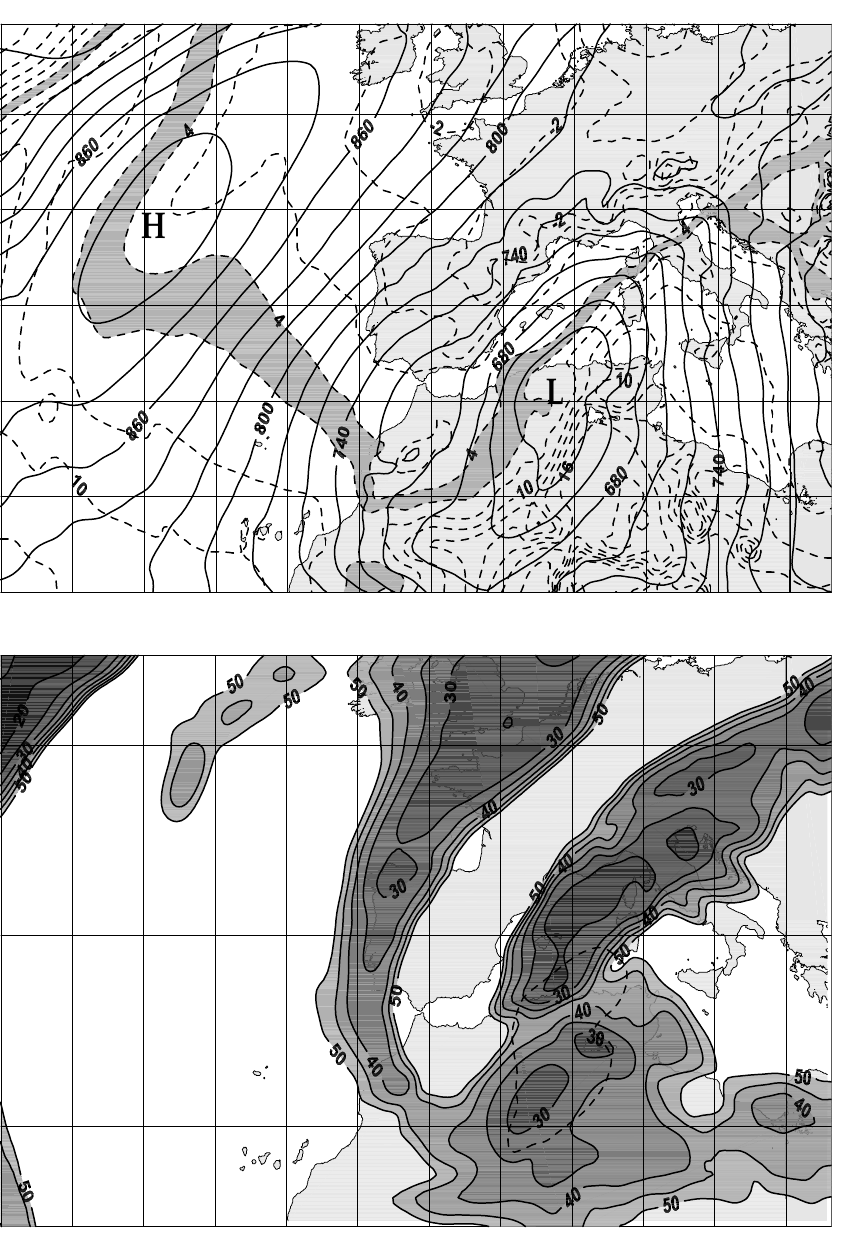
Fig. 11. C20–22 Simulation. e- folding time (hours) shorter than 50h for the most unstable wave, as diag- nosed by the linear shear baroclinic in- stability Eady model for 00:00UTC, 21December (T+24). Dashed line de- picts the 1000hPa isobar surrounding the low